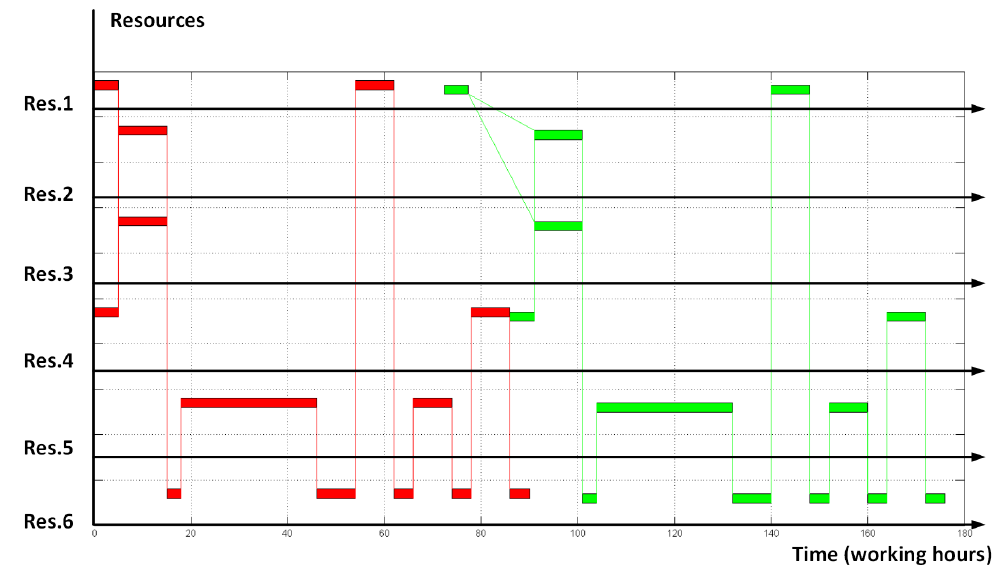
Figure 6. Gannt diagram for starting point of two orders schedule